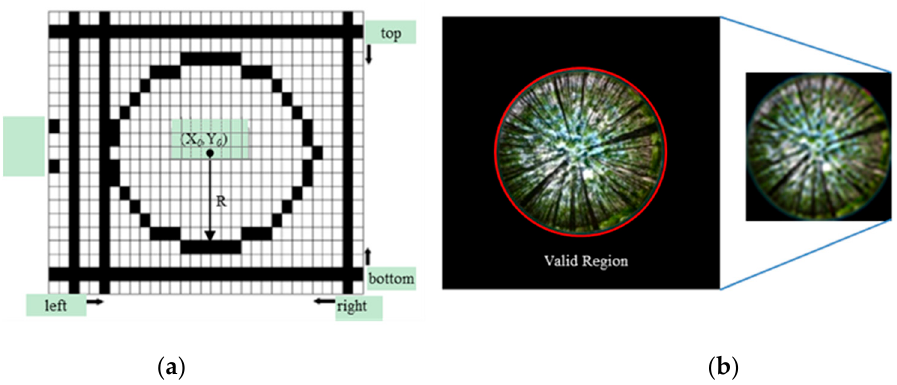
Figure 4. The principle of the scanning algorithm and the valid region. ( a ) Algorithm interpretation; ( b ) valid region shown by the red circle.